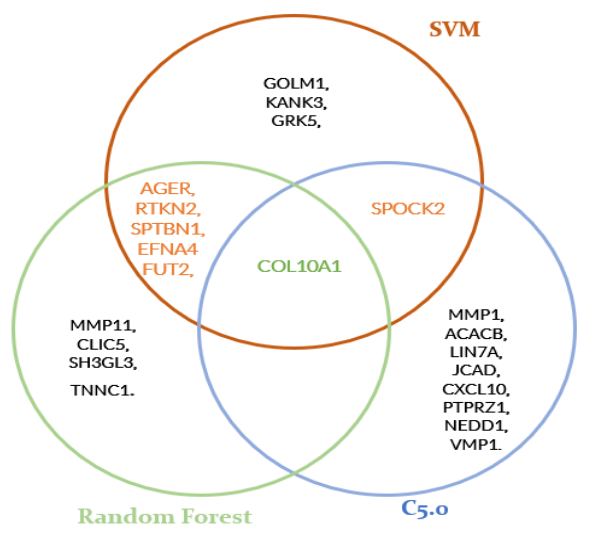
Figure 2. Relations between SVM, random forest and C5.0